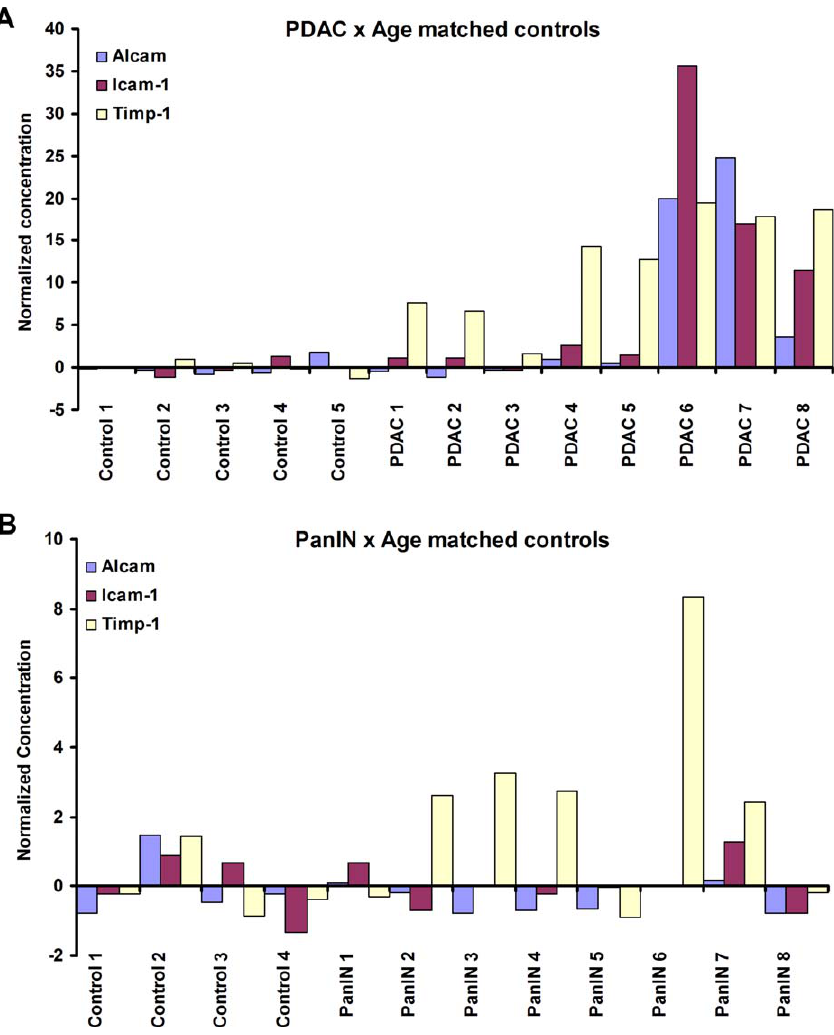
Figure 5. Validation Study of ALCAM, ICAM1, and TIMP1 in Mouse Plasma by ELISA (A) Plasma from the same individual mice used for proteomics discovery were utilized for validation by means of ELISA. ALCAM, TIMP1, and ICAM1 were all elevated in plasma of the PDAC mice. (B) TIMP1 was also elevated in plasma of PanIN mice. ALCAM overall (cancer plus controls) concentration in mouse plasma was 19 ng/ml; ICAM1 was 163 ng/ml; and TIMP1was 6.2 ng/ml. The low ng/ml concentrations of these proteins support the substantial depth of analysis achieved with our discovery platform. Normalization of concentration was performed as described in the Materials and Methods.